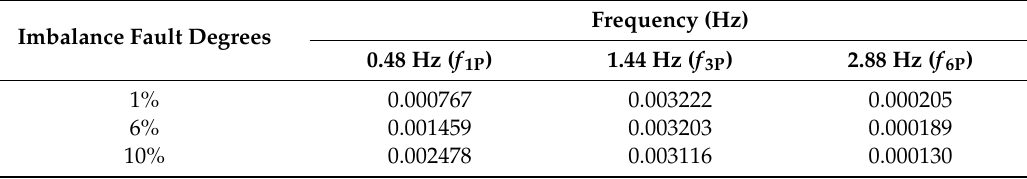
Table 3. Amplitude of fault frequency for di ff erent degree of